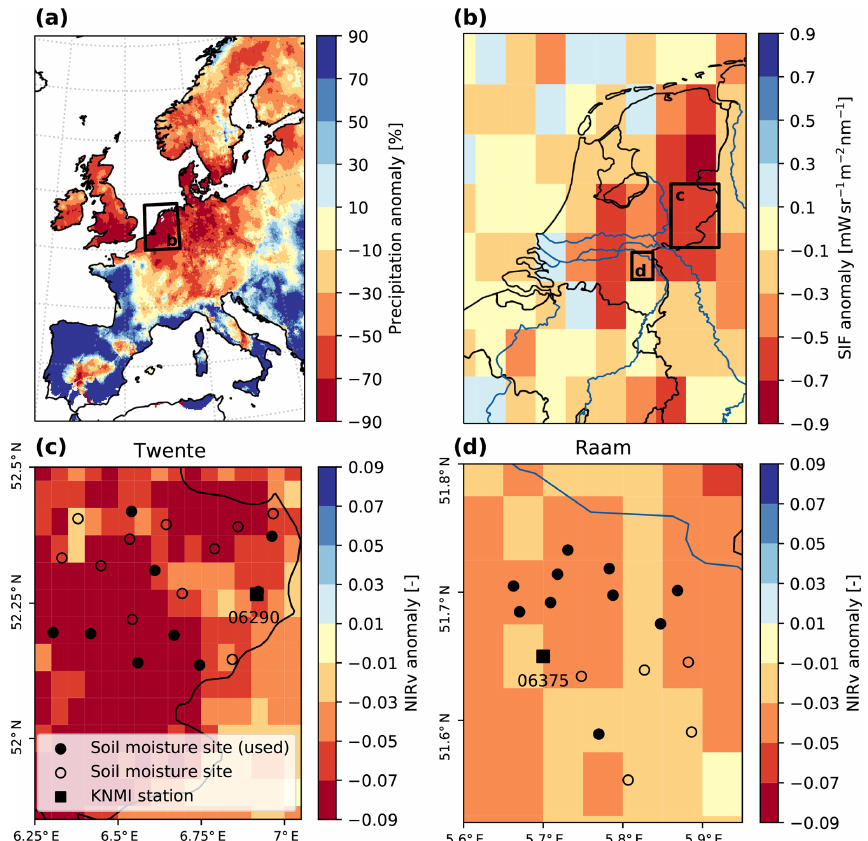
Figure 1. Distribution of the 2018 summer drought and vegetation productivity with respect to 2016 and 2017. Drought distribution in western Europe (a) is expressed by the relative June–July precipitation anomaly (E-OBS), showing that the eastern part of the Netherlands was one of the worst hit areas. This is confirmed by a similar pattern in GOME-2 SIF anomalies (b) . MODIS NIRv (c, d) shows a similar distribution but at much higher spatial resolution, for Twente (c) and Raam (d) . The circles indicate in situ soil moisture measurement sites with (filled) and without data of sufficient availability (open); when filled these are included in the analyses. KNMI stations Twenthe (06290) and Volkel (06375) are indicated by black